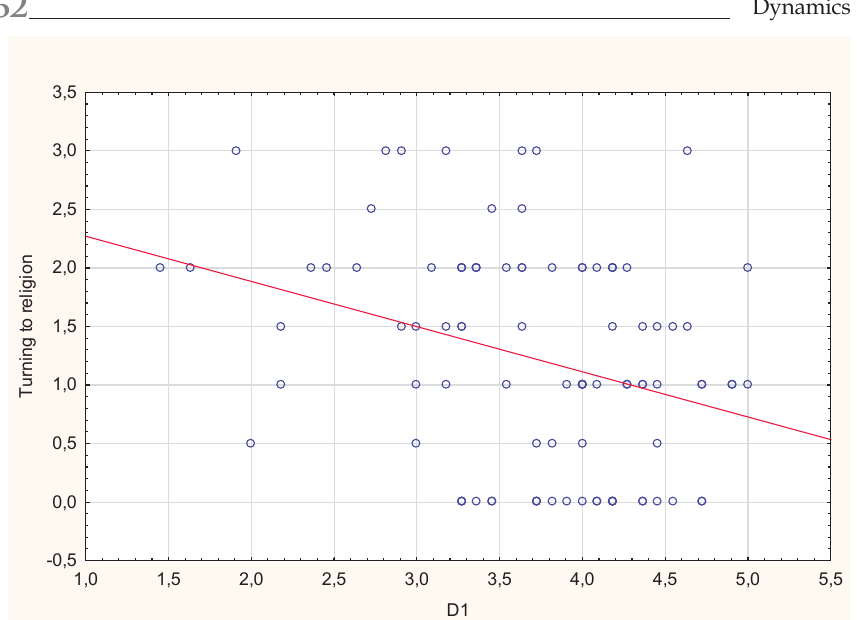
Figure 2. (cid:55)(cid:75)(cid:72)(cid:3)(cid:86)(cid:70)(cid:68)(cid:87)(cid:87)(cid:72)(cid:85)(cid:3)(cid:71)(cid:76)(cid:68)(cid:74)(cid:85)(cid:68)(cid:80)(cid:3)(cid:178)(cid:3)(cid:55)(cid:88)(cid:85)(cid:81)(cid:76)(cid:81)(cid:74)(cid:3)(cid:87)(cid:82)(cid:3)(cid:85)(cid:72)(cid:79)(cid:76)(cid:74)(cid:76)(cid:82)(cid:81)(cid:3)(cid:87)(cid:82)(cid:3)(cid:83)(cid:75)(cid:92)(cid:86)(cid:76)(cid:70)(cid:68)(cid:79)(cid:3)(cid:90)(cid:72)(cid:79)(cid:79)(cid:16)(cid:69)(cid:72)(cid:76)(cid:81)(cid:74)(cid:3)(cid:11)(cid:39)(cid:20)(cid:12)(cid:3)(cid:73)(cid:82)(cid:85)(cid:3)(cid:87)(cid:75)(cid:72)(cid:3) (cid:68)(cid:81)(cid:68)(cid:79)(cid:92)(cid:93)(cid:72)(cid:71)(cid:3)(cid:74)(cid:85)(cid:82)(cid:88)(cid:83)